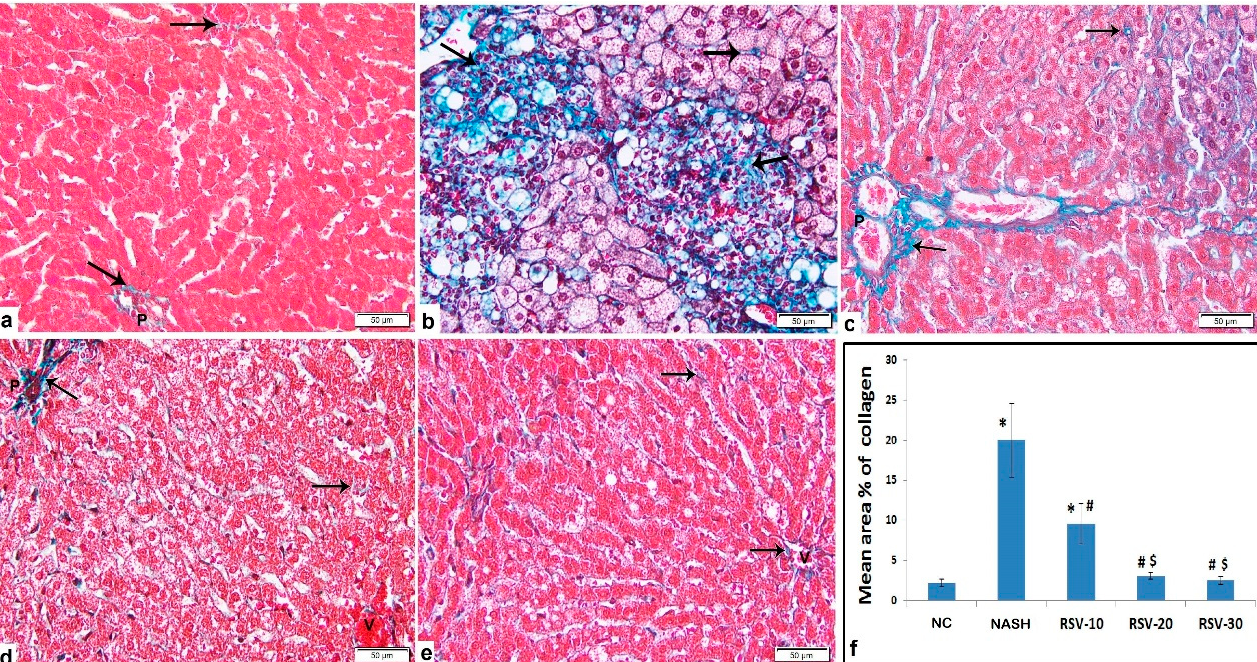
Figure 3. Photomicrographs of Masson trichrome ‐ stained liver sections show: ( a ) Control: fine collagen fibers among hepatocytes and around the portal tract. ( b ) NASH: marked collagen deposition in multiple large areas in association with inflammatory cells infiltration and macro ‐ vesicular steatosis, in addition to pericellular/perisinusoidal fibrosis. ( c ) RSV ‐ 10: increased peri ‐ portal collagen deposition and among hepatocytes. ( d , e ) RSV ‐ 20 and RSV ‐ 30: fine collagen fibers. [Arrow: collagen deposition; P: portal tract; V: central vein]. [Magnification: 200×]. ( f ) The mean area % of collagen deposition (±SD) in the NC and the experimental groups: * p < 0.05 compared to the control group; # p < 0.05 compared to NASH; $ p < 0.05 compared to RSV ‐ 10.